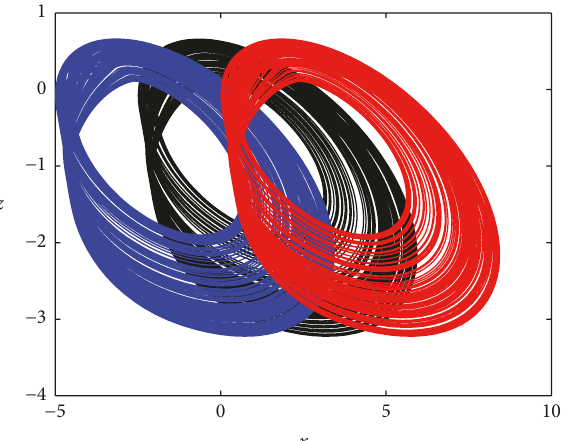
Figure 5: Variable chaotic attractor when varying the control parameter 𝑘 𝑥 : black color for 𝑘 𝑥 = 0 , blue color for 𝑘 𝑥 = −2 , and red color for 𝑘 = 2 𝑥